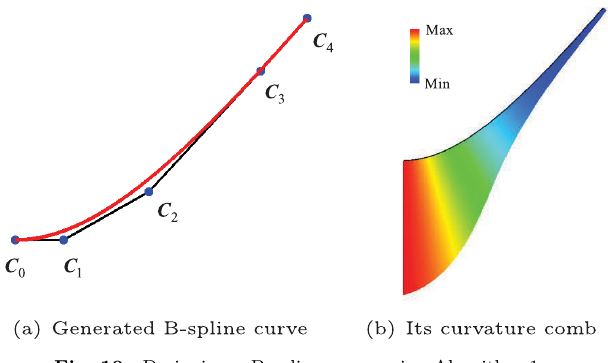
Fig. 10 Designing a B-spline curve using Algorithm 1.